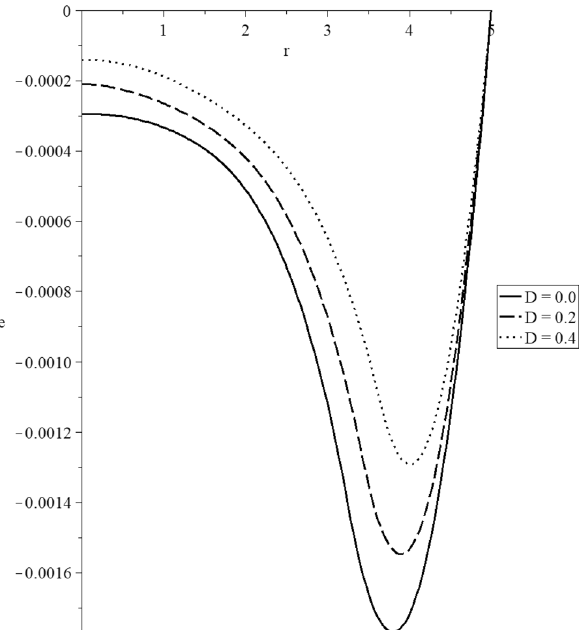
Figure 11. The volumetric deformation distribution with various values of the mechanical damage parameter.